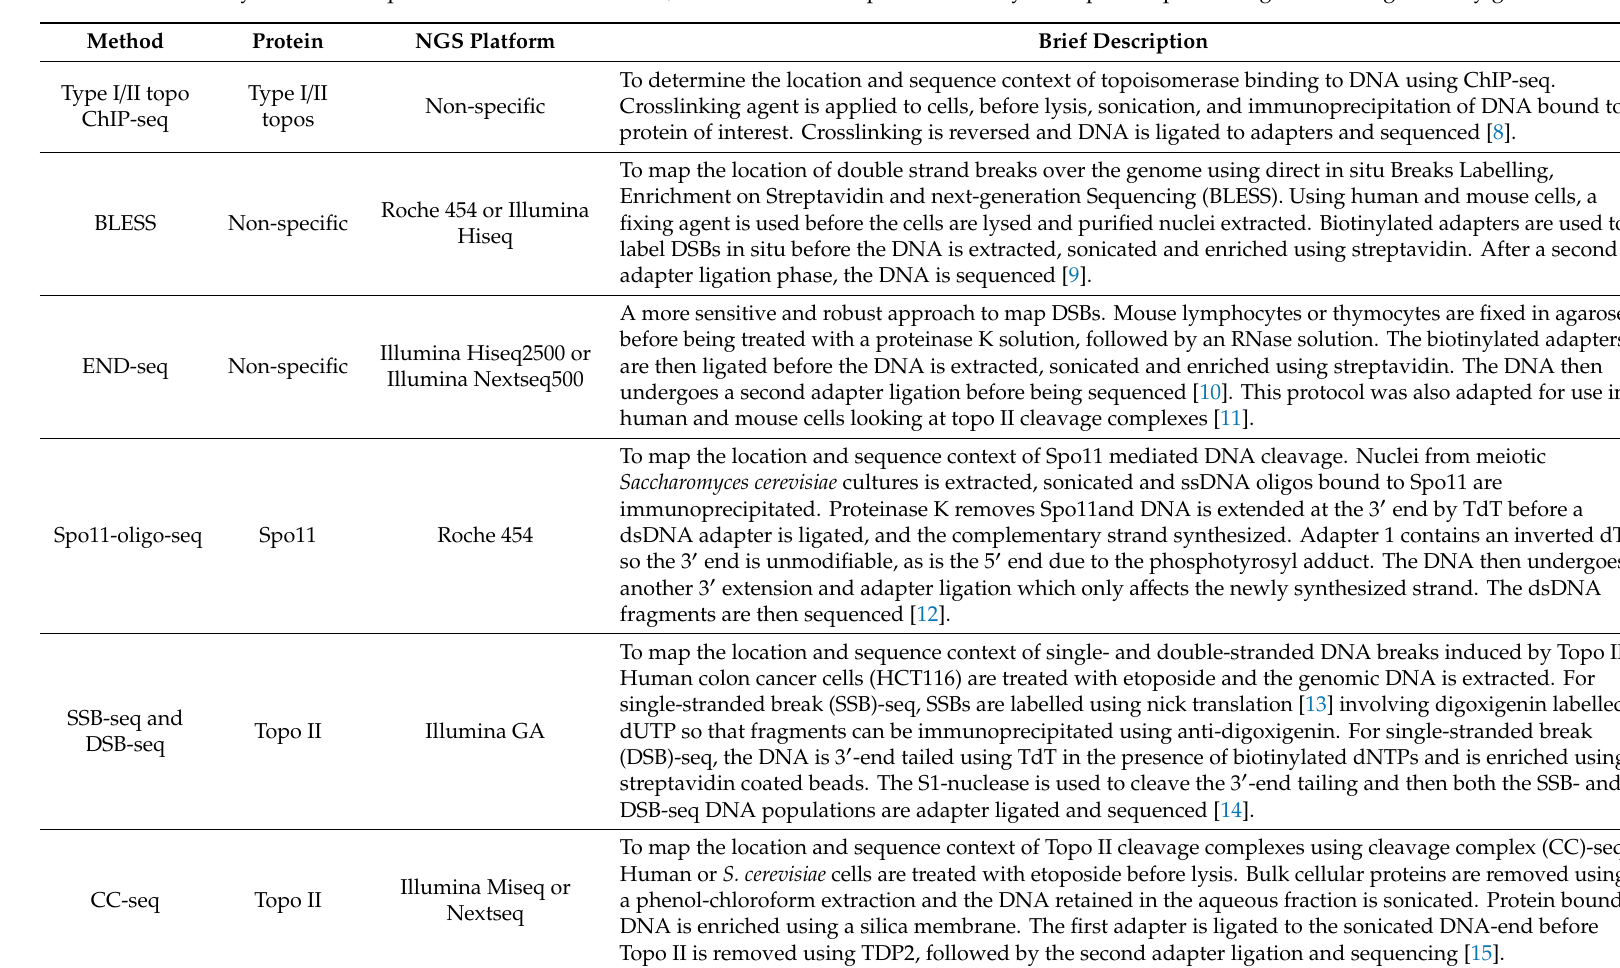
Table 1. A summary of the techniques discussed in this review, which were developed to find ways to explore topo binding and cleavage activity genome